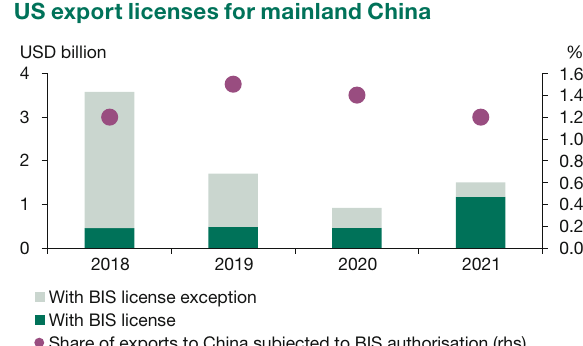
US approval rate for export licenses